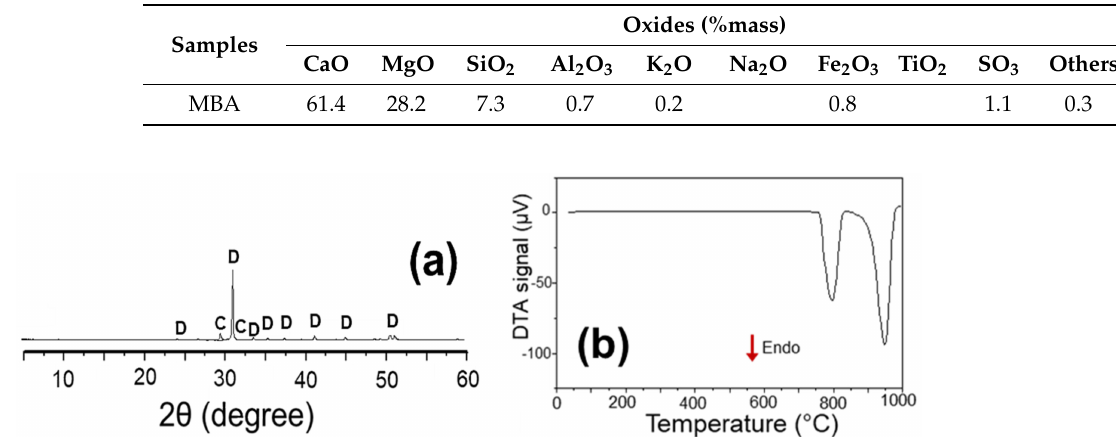
Figure 5. X-ray diffraction pattern ( a ) and DTA curve ( b ) obtained from the marble sample. C—calcite,